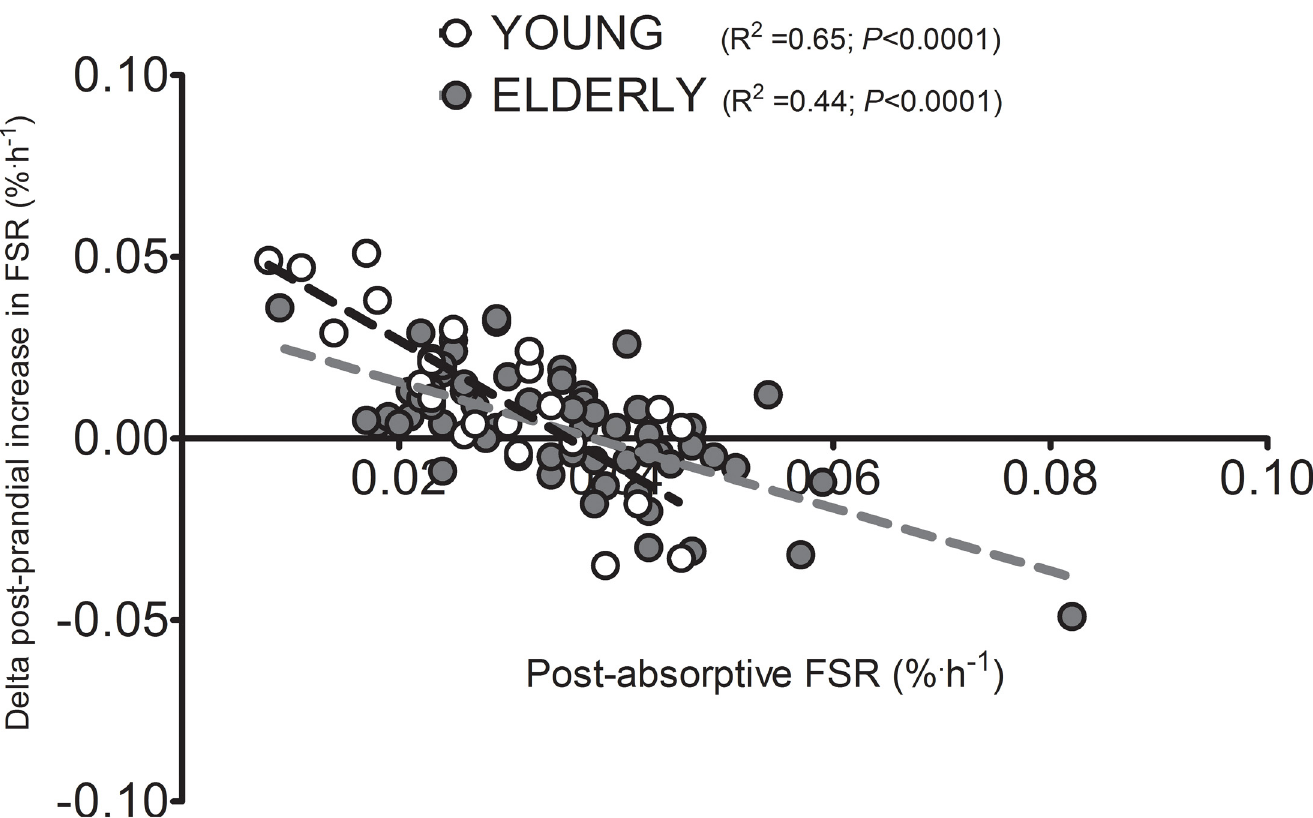
Fig 4. Correlation between post-absorptive fractional mixed muscle protein synthesis rates (FSR) and the delta increase in FSR following the ingestion dietary protein (post-prandial) in healthy young ( n = 22) and elderly ( n = 68) men. Data were analyzed with 2-tailed tests of significance by using Pearson's correlation